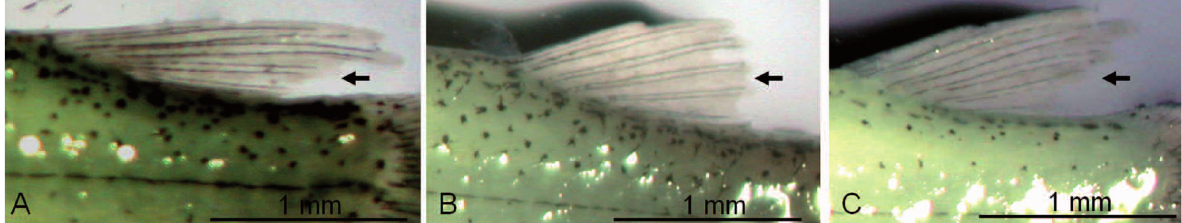
Fig. 4. Characteristics of the dorsal fin of untreated ( A ) male and ( B ) female of Thai medaka, Oryzias minutillus ; (C) Dorsal fin of male exposed to 1 µg · mL –1 pendimethalin for 60 days